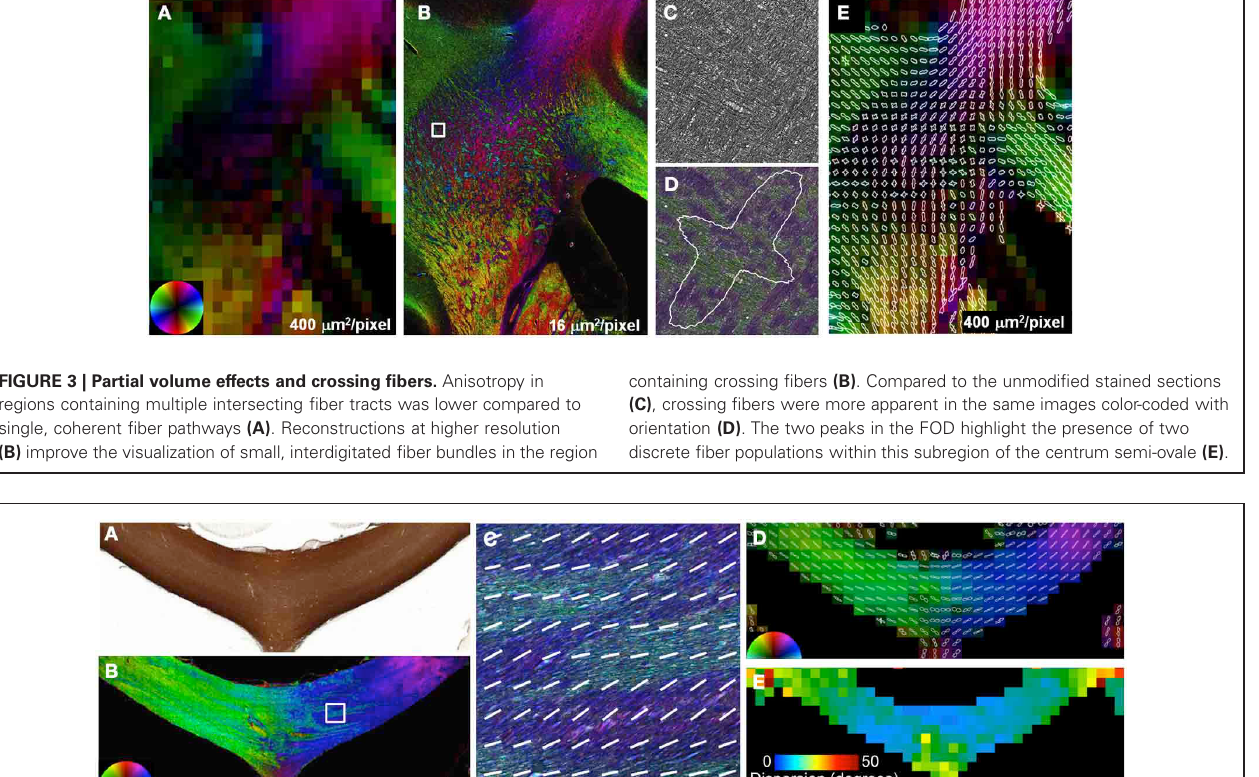
FIGURE 4 | Angular dispersion of the corpus callosum. In the body of the CC (A) , the microscopic heterogeneity is apparent on images color coded by orientation reconstructed at high resolution (B and C) . The FODs (D) were fit